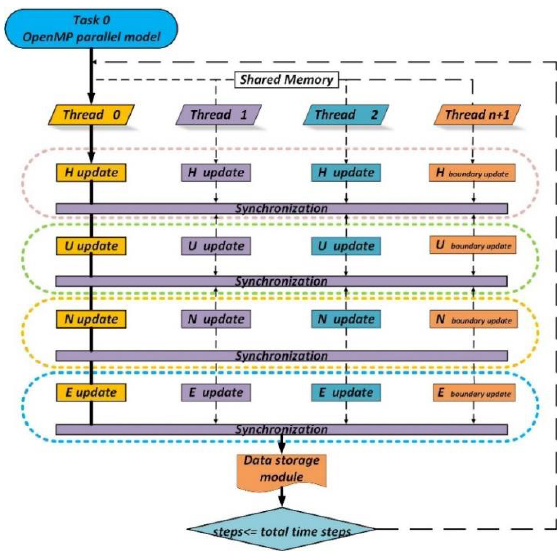
Figure 4. Update module calculation